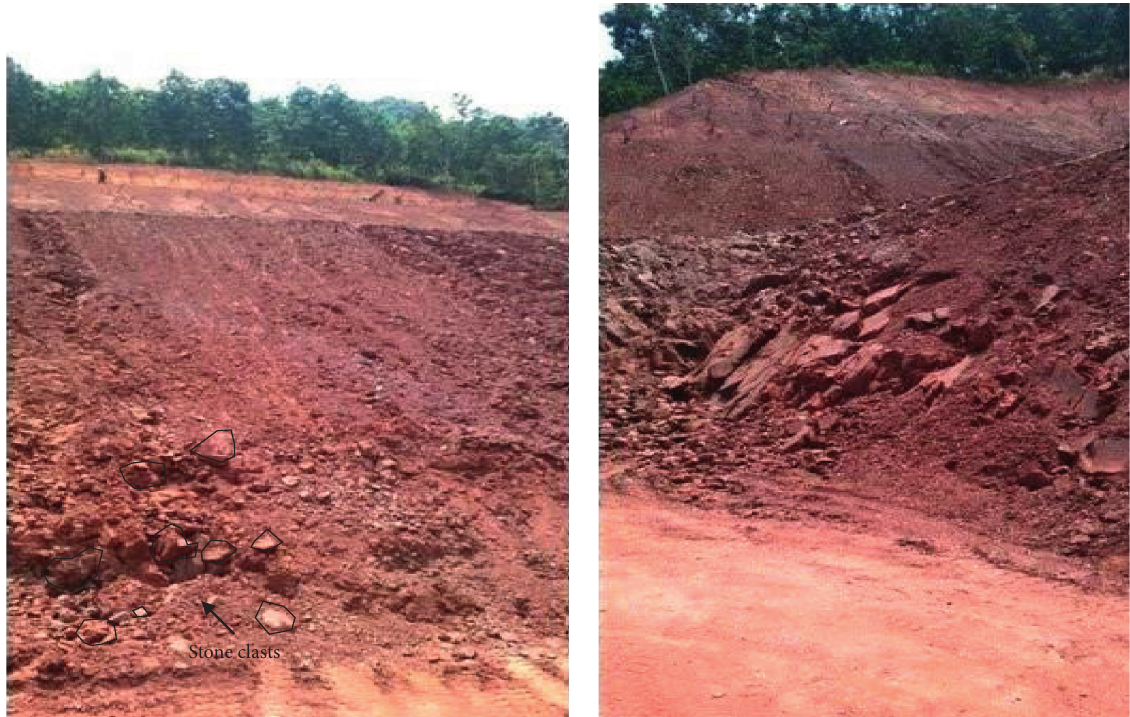
Figure 1: Surface of the highway slope along XiaoMo highway in Yunnan